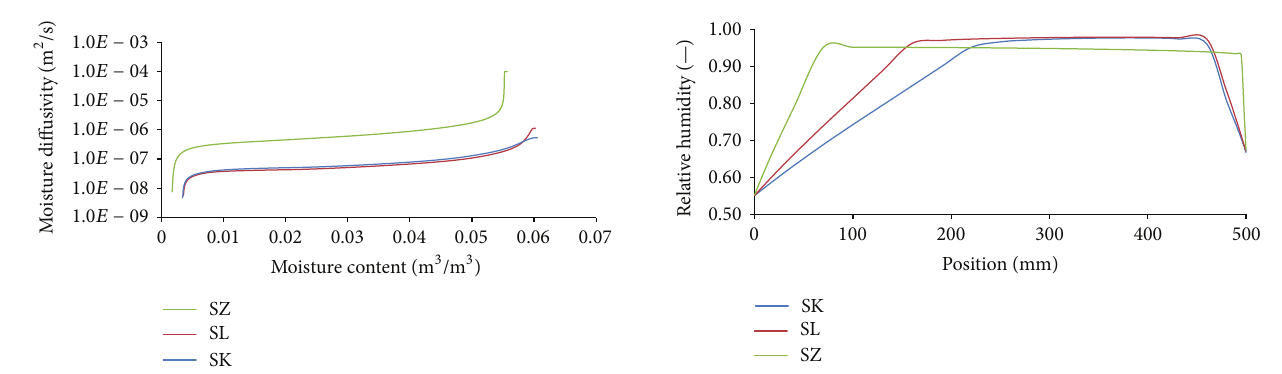
Figure 8: Relative humidity profiles, ˇSer´ak’s climatic conditions, January 15, 3:00 a.m.